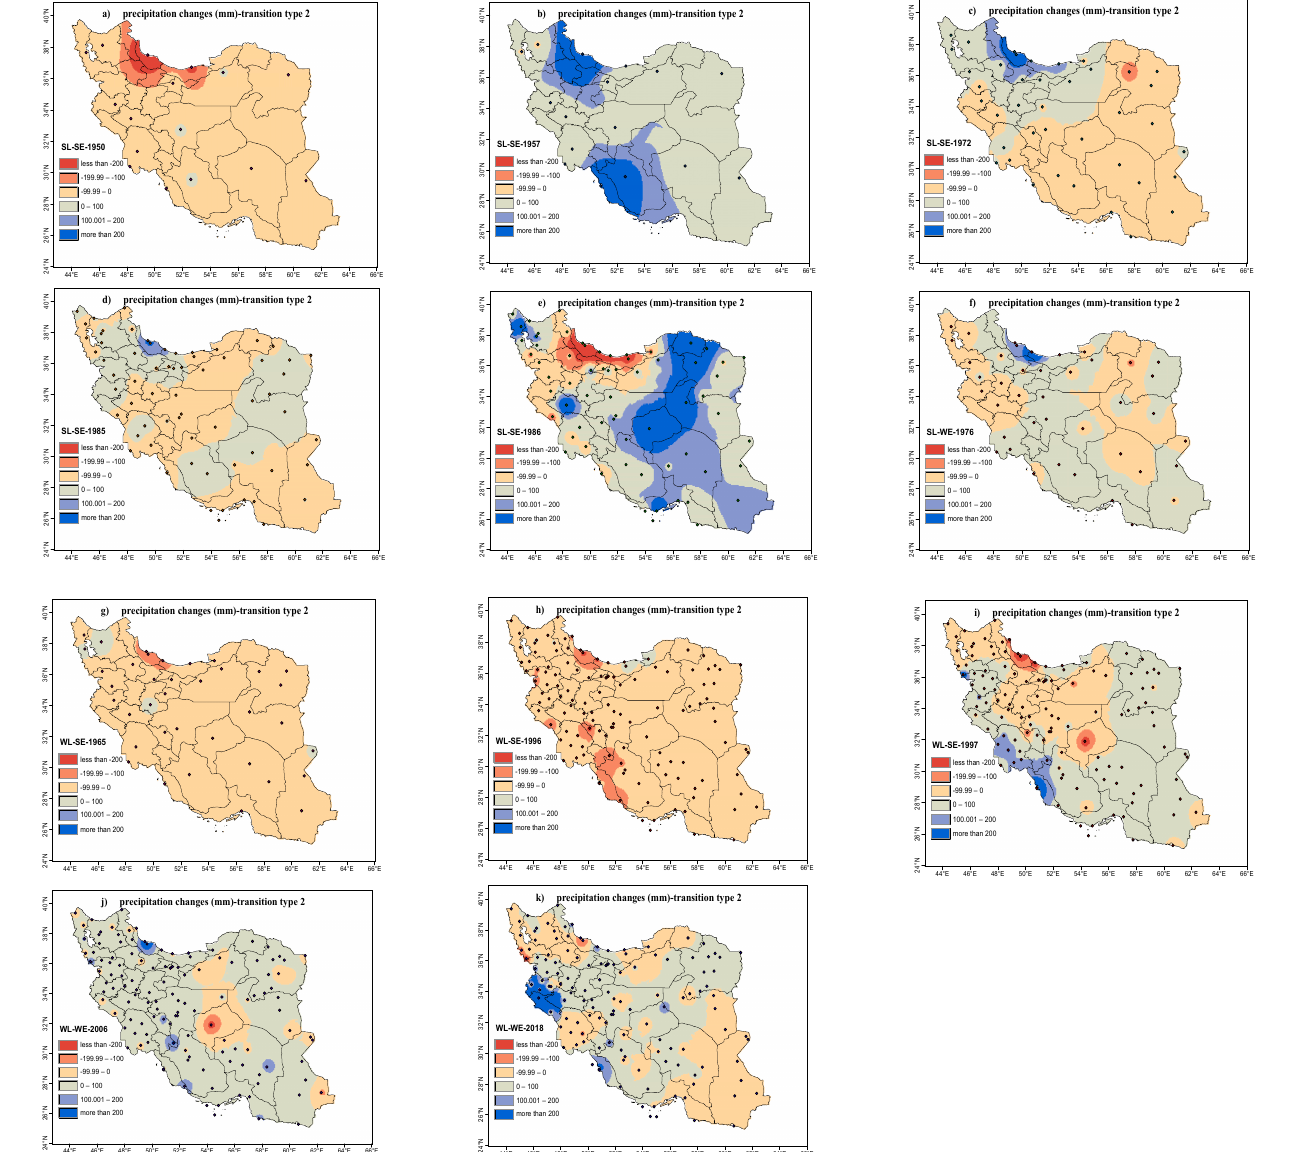
Figure 2. Same as Figure 1, but for type 2 transition years.